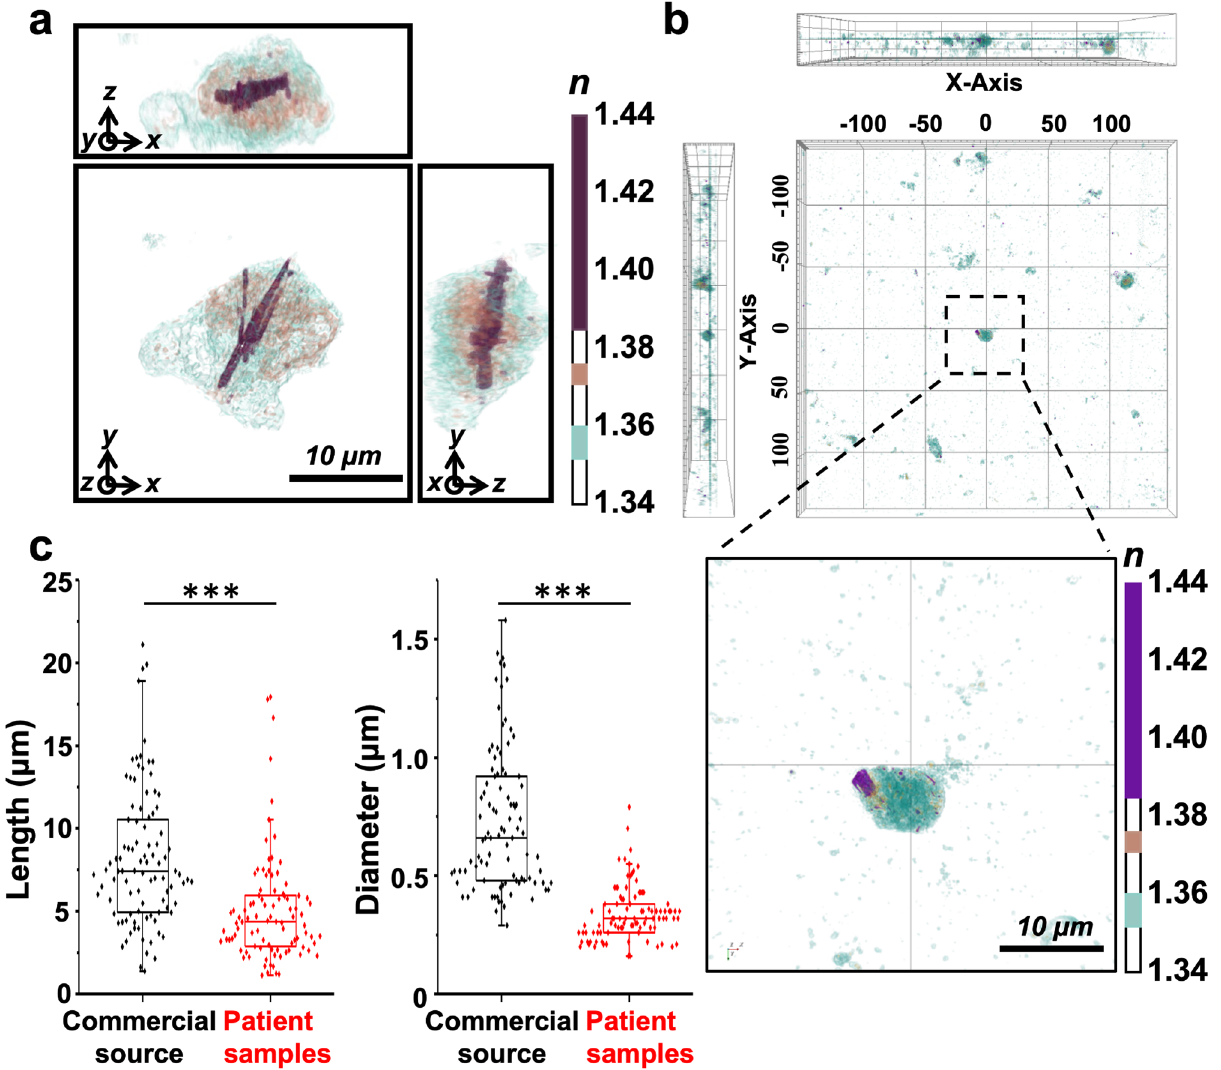
Figure 3. Monosodium urate (MSU) crystals acquired from patients with gout were compared with synthetic MSU crystals. ( a ) Three-dimensional (3D) holotomographic image of MSU crystals embedded in the patient cells. The color bar indicates the 3D rendered RI distribution range (n = 1.340–1.440). Each square shows the x–y, y–z, or x–z plane. n: refractive index. Additionally, see Supplementary Movie S3. ( b ) Extensive monitoring of MSU crystals from a synovial fluid sample through stitch mode of holotomographic imaging (300 µm × 300 µm). The boxed region is enlarged in the lower panel. ( c ) Comparison of patient crystals with commercial MSU crystals (n = 96). Data are represented as the mean ± SD values. *** P <